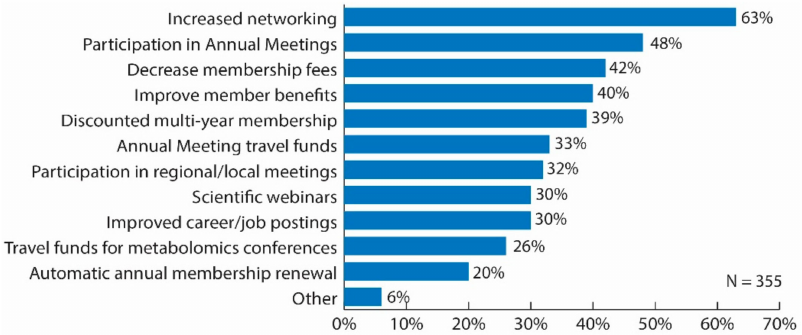
Figure 5. Bar graph of survey results for question: “What are the best strategies for the Metabolomics Society to increase membership? Choose all that apply.” Original data used to create the figure can be found in the supplementary information under question number